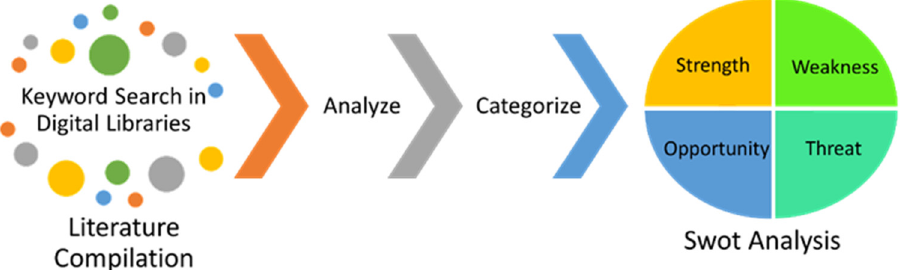
Figure 9. Methodology used for selecting literature for the study and classifying them for the SWOT analysis. analysis.